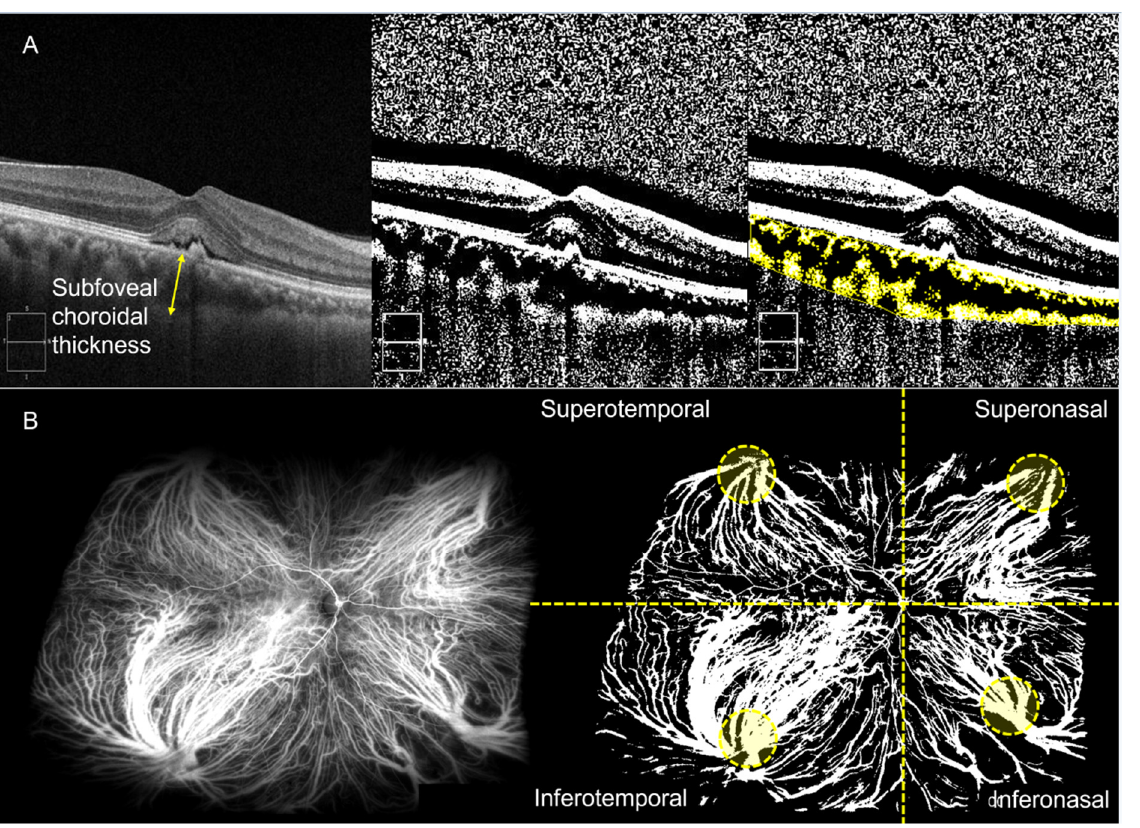
Figure 1. Imaging analysis with ultra-widefield indocyanine angiography (UWICGA). ( A ) Analysis of optical coherence tomography (OCT) B-scan image intersecting the center of the fovea. a. Subfoveal choroidal thickness was measured as the distance between Bruch’s membrane and the choroid–scleral border at the fovea (yellow arrow). The OCT image was binarized using “Niblack” thresholding, and the choroidal vessel density (CVD) was measured as the ratio of vascular area (black pixels) to stromal area (white pixels). ( B ) Analysis of UWICGA images. UWICGA image was binarized using “MidGrey” thresholding. CVD was calculated by dividing the number of pixels in the vascular area (white pixels) by that of the total measurable retinal area (blue dash area). Vessel densities were measured for total area, each quadrant, and each ampulla area of the quadrant.